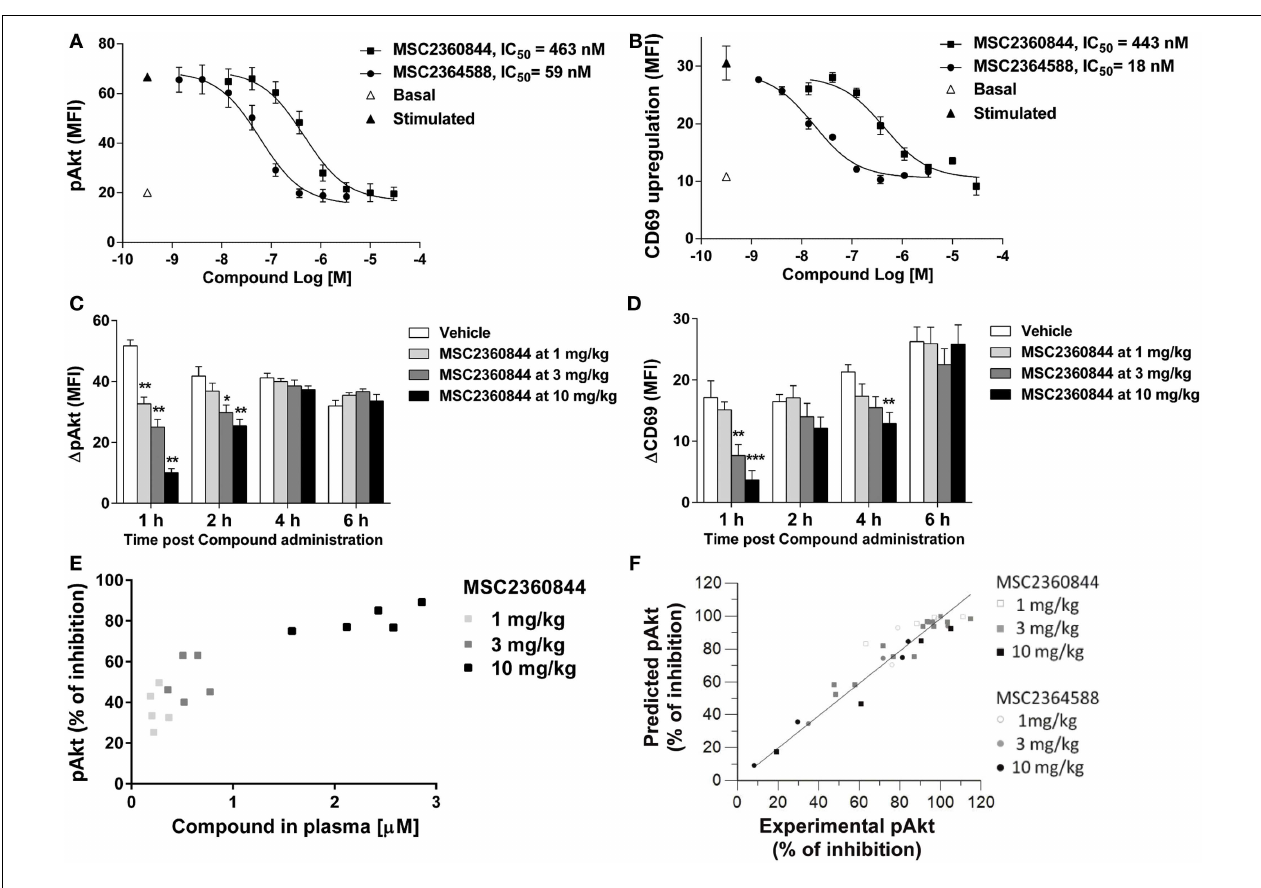
measured as in (A) . ∆ pAkt was calculated by subtracting basal from stimulated signal. In (D) , surface CD69 was measured as in (B) . ∆ CD69 was calculated by subtracting basal from stimulated signal. Data are shown as mean ± SEM with five mice per group. Data were analyzed by one-way ANOVA followed by Dunnett’s post-tests compared with vehicle group. ** p < 0.01, *** p < 0.001. (E) MSC2360844 concentrations in plasma were plotted against percentage of pAkt inhibition at 1h time point in the experiment described in (C) . (F) PK/PD model using percentage of pAkt inhibition readout based on data obtained from (A,B) . Points represent the average of pAkt (% of inhibition) of five animals at a single time or dose of a